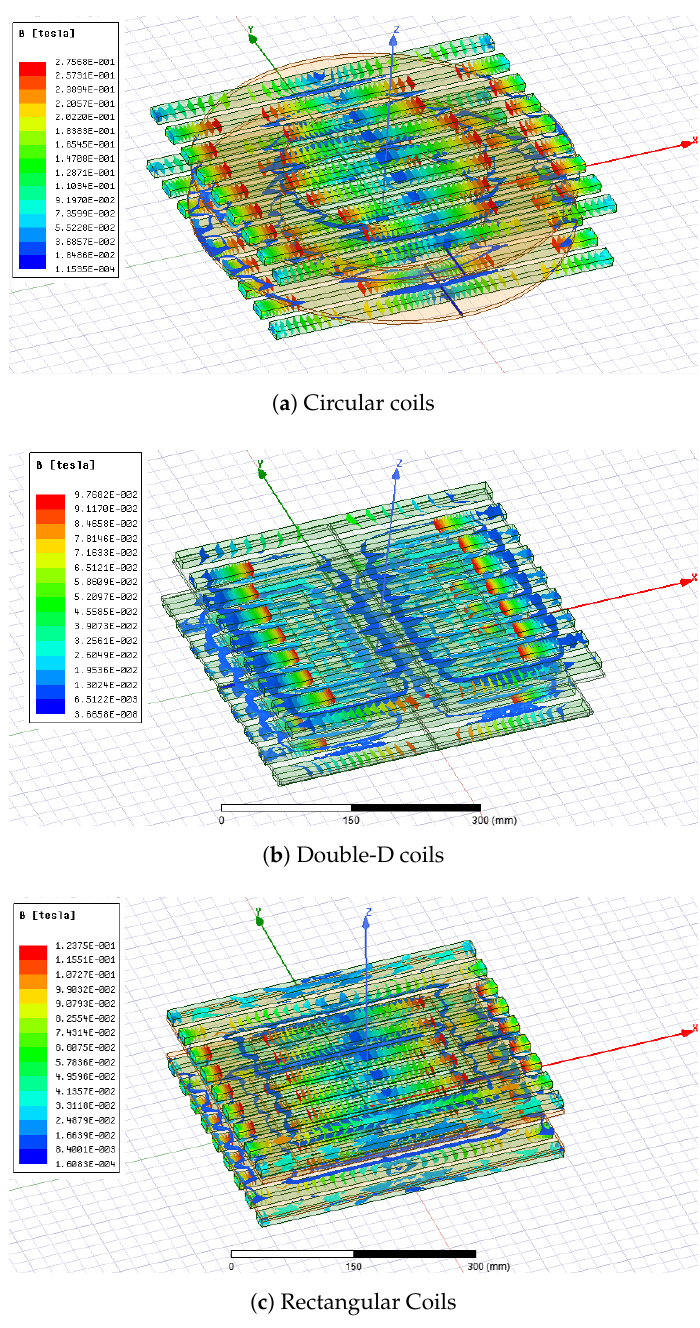
Figure 2. Three-dimensional magnetic field distribution in three coil geometries with 50 mm axial